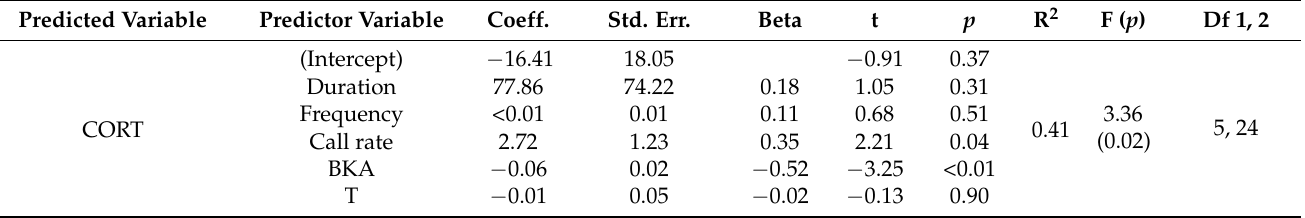
Table 3. Analysis of behavioral (note duration, dominant frequency, and call rate); physiological (testosterone, T); and immunological (bacterial killing ability, BKA) factors that significantly interact with corticosterone (CORT) determined using multiple linear regression analysis. Call rate and BKA represents significant correlation ( p < 0.05) with the CORT.